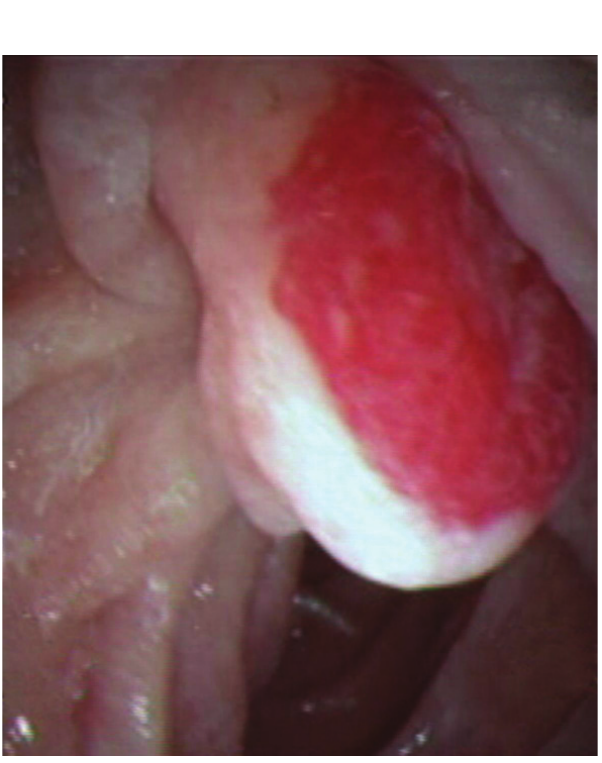
Figure 1 - Endoscopic image of the vascular lesion on the major duodenal papilla with complete involvement of the ostium (head